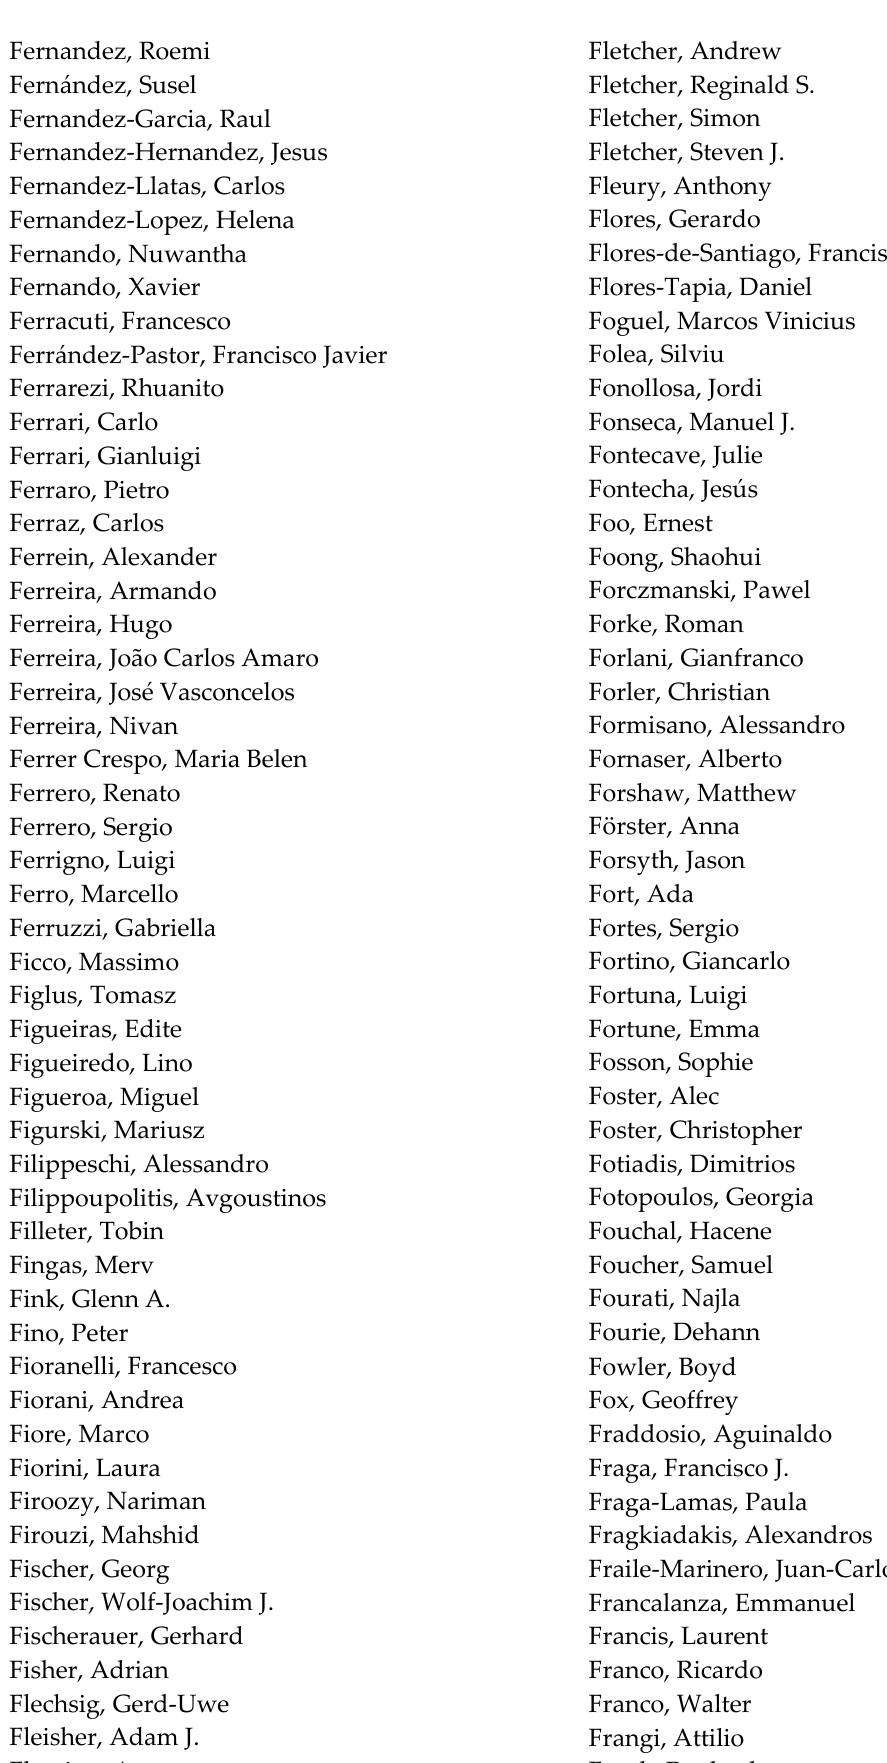
Figlus, Tomasz Figueiras, Edite Figueiredo, Lino Figueroa, Miguel Figurski,